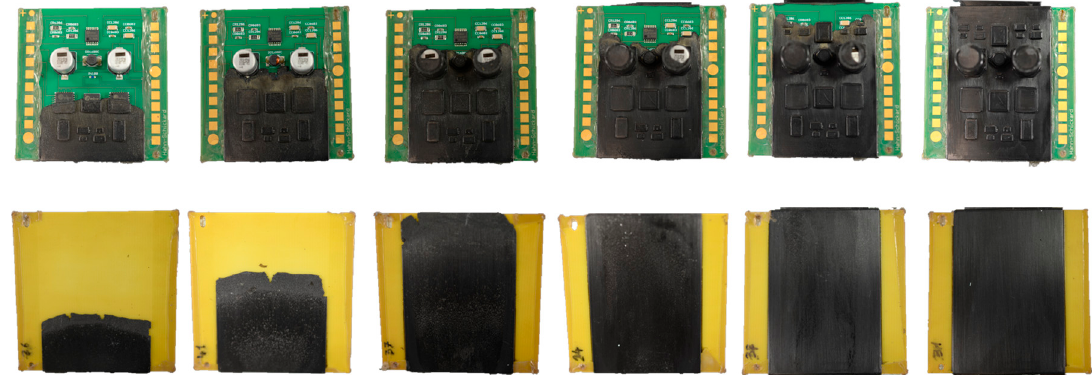
Figure 4. Results of mold trials. The upper row shows the front (mounted) side, and the lower row shows the hind (unmounted) side.